Question: Describe this figure in one sentence.
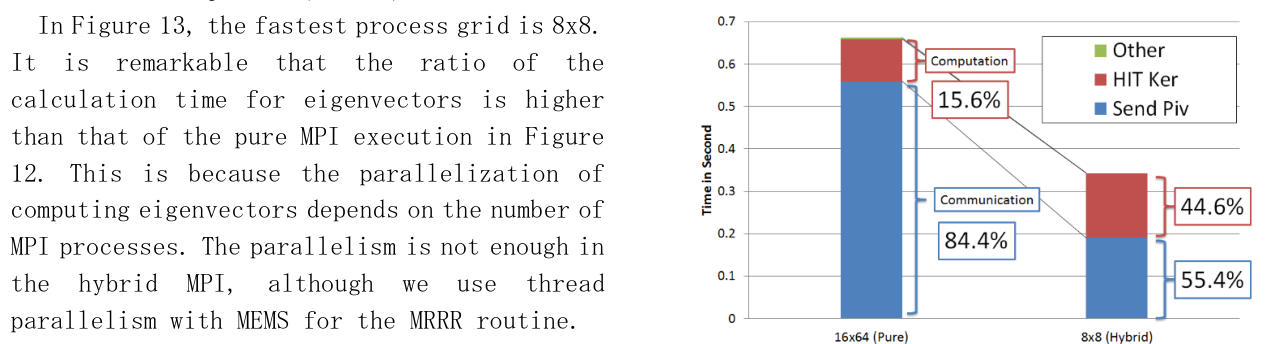
Answer: Comparison of the best pure and hybrid MPI